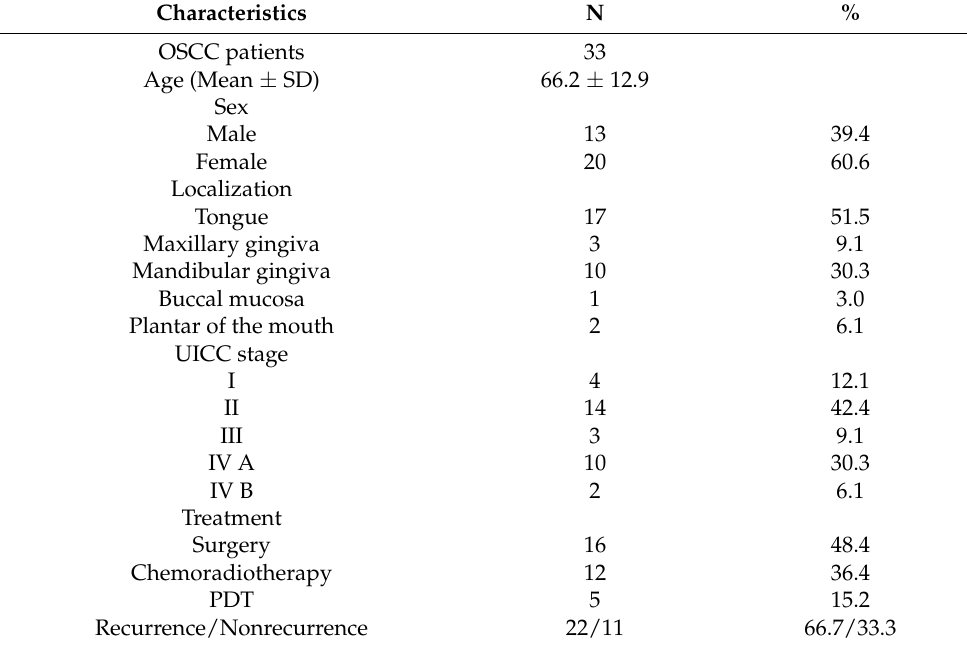
Table 1. OSCC patients and tumor